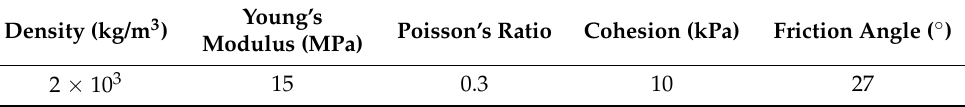
Table 2. Physical and mechanical parameters of the semi-solid hard clay slope.